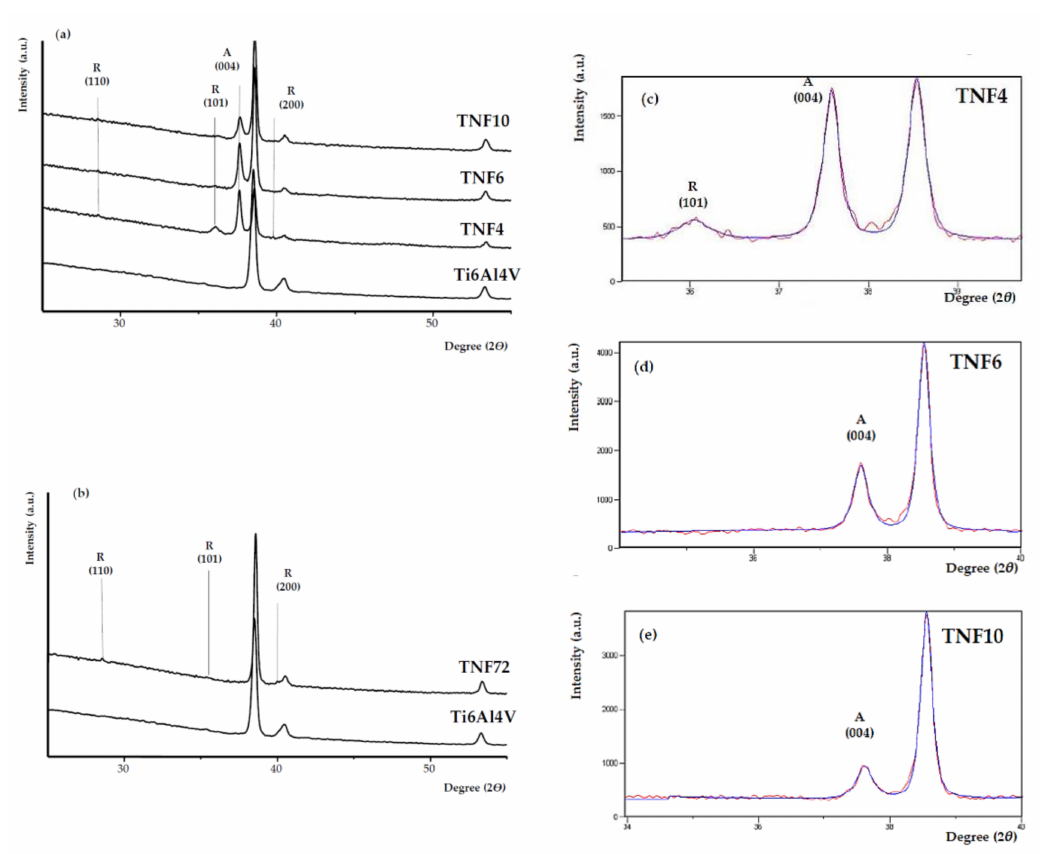
Figure 3. XRD patterns of TNF4–10 ( a ) and TNF72 ( b ) samples, and the Ti6Al4V substrate pattern as a reference sample (TiO 2 anatase phase (A) and rutile example (R)). Changes of the A(004) and R(101) peaks’ intensities of the TNF4–10 samples, showing the broadening and reduction in intensity at di ff erent oxidations time t = 4 h ( c ), 6 h ( d ) and 10 h ( e